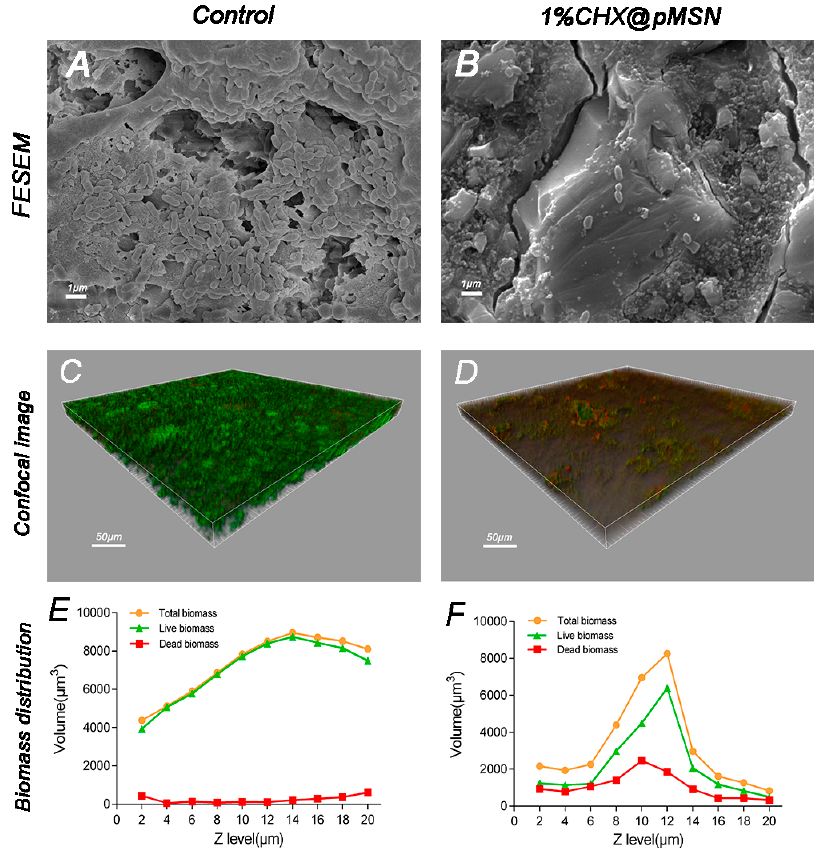
Figure 4. FESEM and CLSM evaluation of S. mutans biofilms. (Top) FESEM images of ( A ) control; and ( B ) 1% CHX@pMSN groups. (Middle) CLSM 3D overlay projections of ( C ) control; and ( D ) 1% CHX@pMSN groups. (Bottom) Corresponding distribution of live/dead bacteria biomass at each layer of Z-stack from ( E ) control; and ( F ) 1% CHX@pMSN groups.